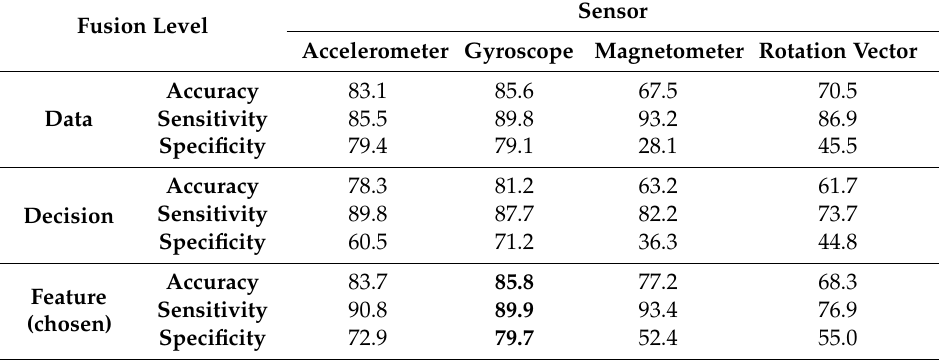
Table 1. Average testing accuracy, sensitivity, and specificity achieved with a deep learning (DL) architecture with different information fusion levels (data-, decision-, and feature-level), and with single sensor data (accelerometer, gyroscope, magnetometer, and rotation vector sensor). Leave-one-subject-out (LOSO) evaluation